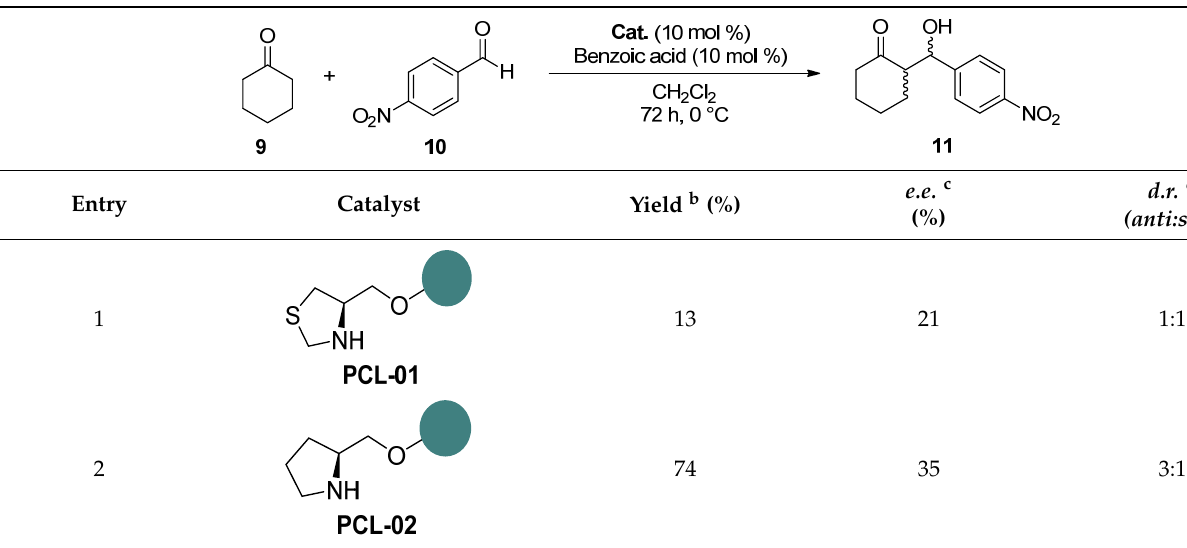
Table 4. Aldol addition reaction between cyclohexanone and p -nitrobenzaldehyde catalyzed by supported compounds PCL-01 to PCL-08 a .